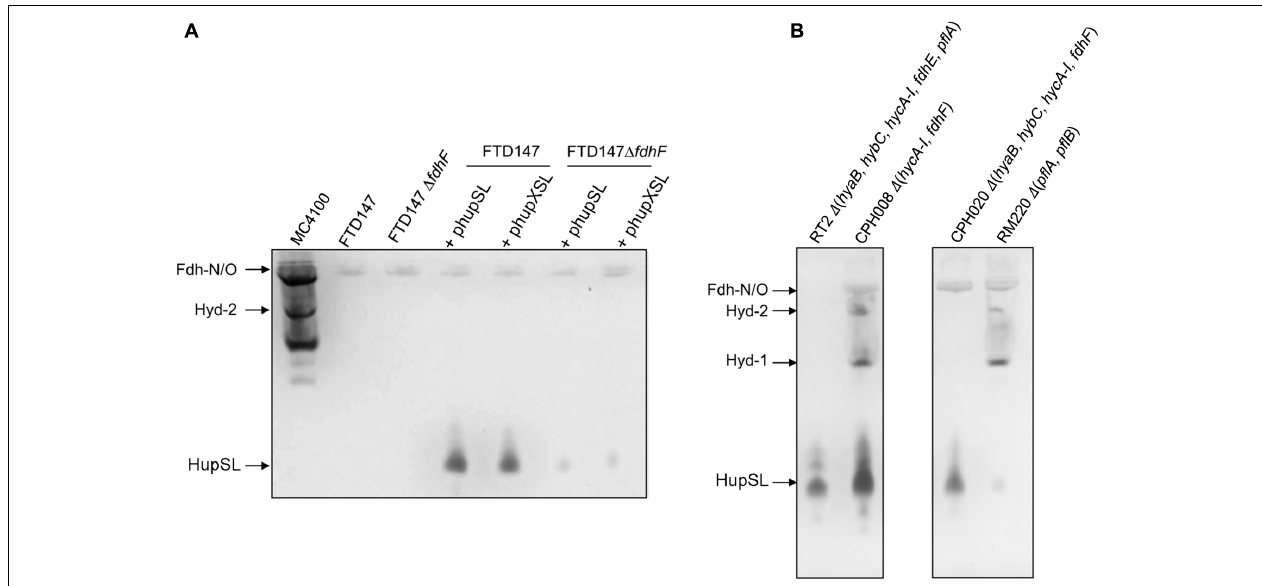
FIGURE 6 | Deletion of the hycA-I operon restores HupSL activity in a fdhF mutant. (A) Crude extracts derived (approximately 60 µ g of protein) from the indicated strains after growth in M9 minimal medium with 0.8% (w/v) glucose were separated in native-PAGE and stained for hydrogenase enzyme activity, as described in the legend to Figure 1 . In (B) , strains were transformed with plasmid phupSL. The migration positions of the respective hydrogen-oxidizing enzymes are indicated. Strain used include: MC4100 represents wild type; FTD147 ( (cid:49) hyaB (cid:49) hybC (cid:49) hycE ); FTD147 (cid:49) fdhF ; RT2 ( (cid:49) hyaB (cid:49) hybC (cid:49) hycA-I (cid:49) fdhE (cid:49) pflA ); CPH008 ( (cid:49) hycA-I (cid:49) fdhF ); CPH020 ( (cid:49) hyaB (cid:49) hybC (cid:49) hycA-I (cid:49) fdhF ); RM220 ( (cid:49) pflA (cid:49) pflB